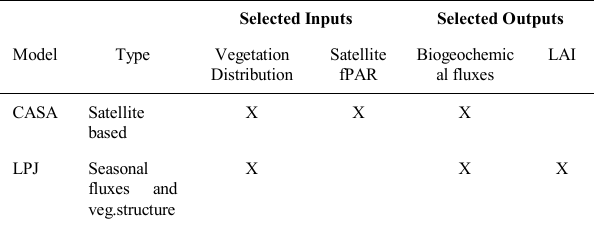
Table 2. Input data categories of CASA and LPJ